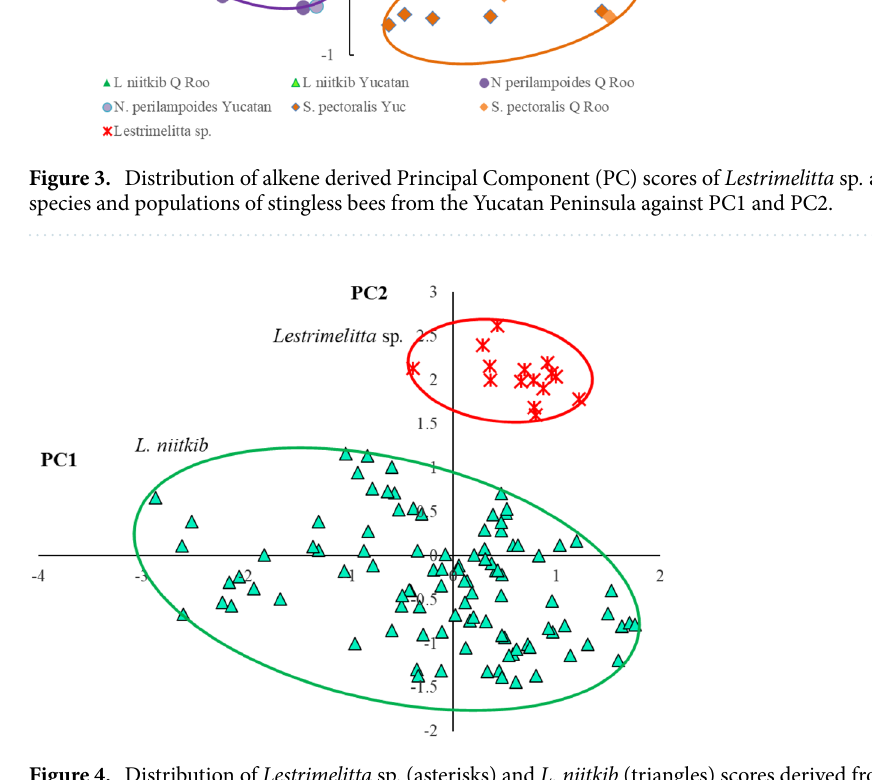
Figure 4. Distribution of Lestrimelitta sp. (asterisks) and L. niitkib (triangles) scores derived from a principal component (PC) analysis of four meristic characters plotted against PC1 and